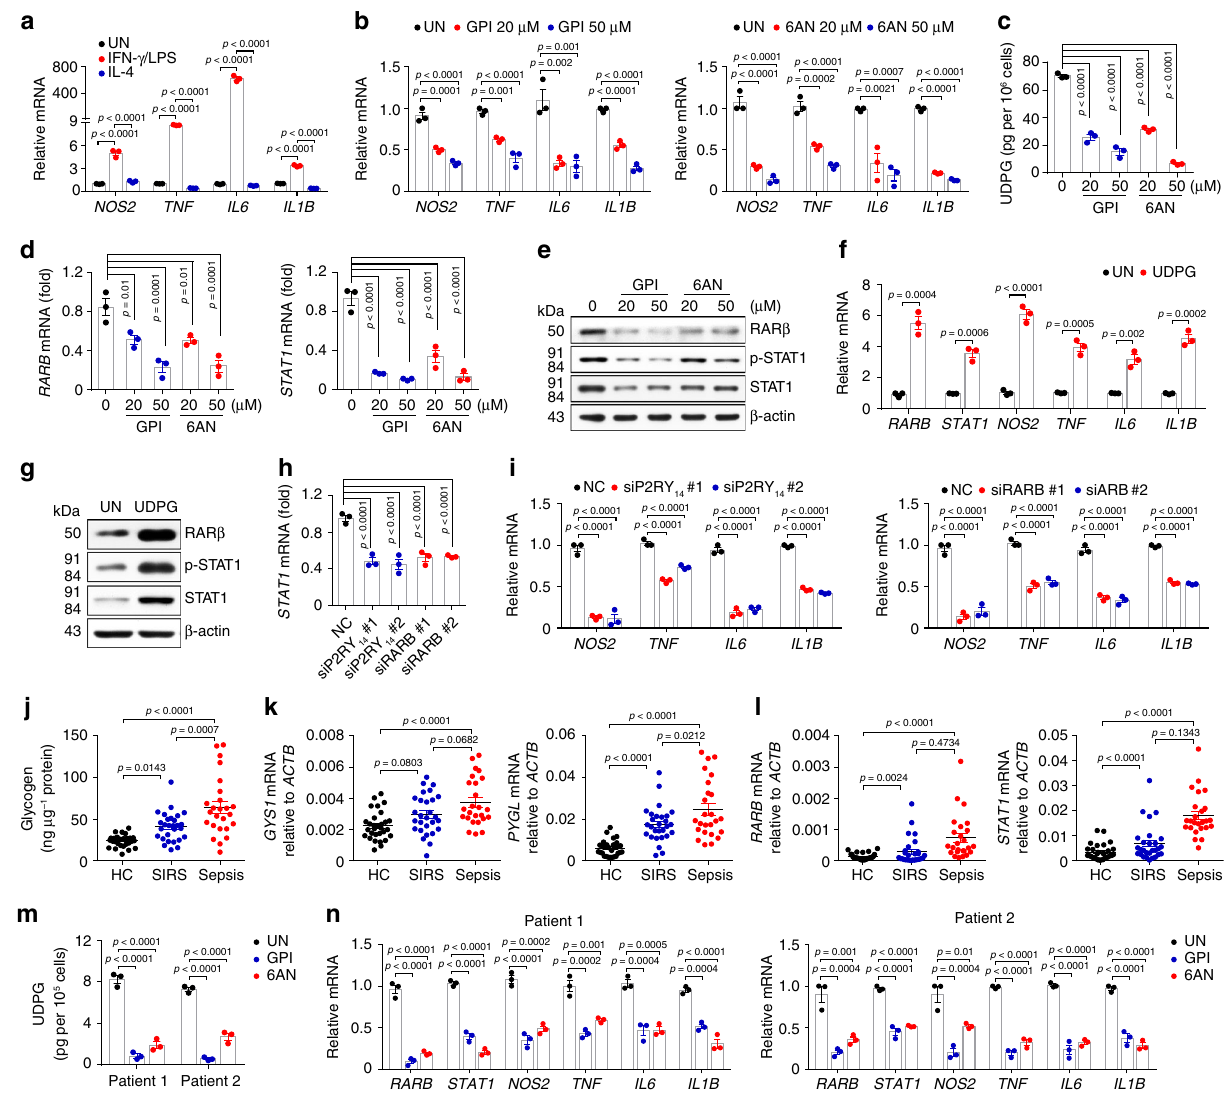
Fig. 8 Macrophage glycogen metabolism regulates sepsis in patients. a THP-1 cells were cultured with PMA (100 ng mL − 1 ) for 3 days and